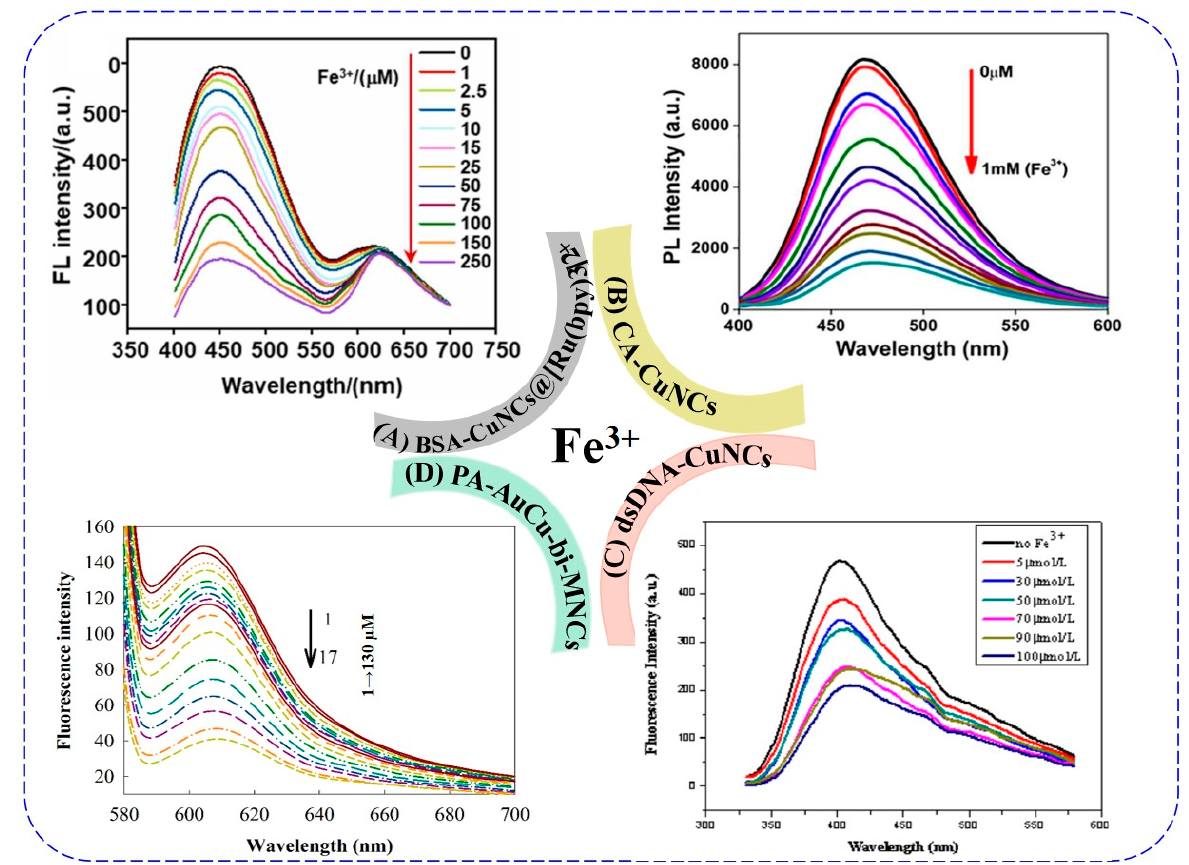
Figure 10. CuNCs for Fe 3+ detection. Fluorescence spectra of different concentrations of Fe 3+ injected